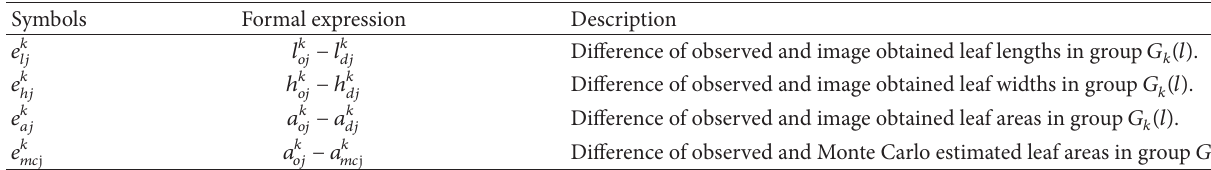
Table 3: Approximation errors.